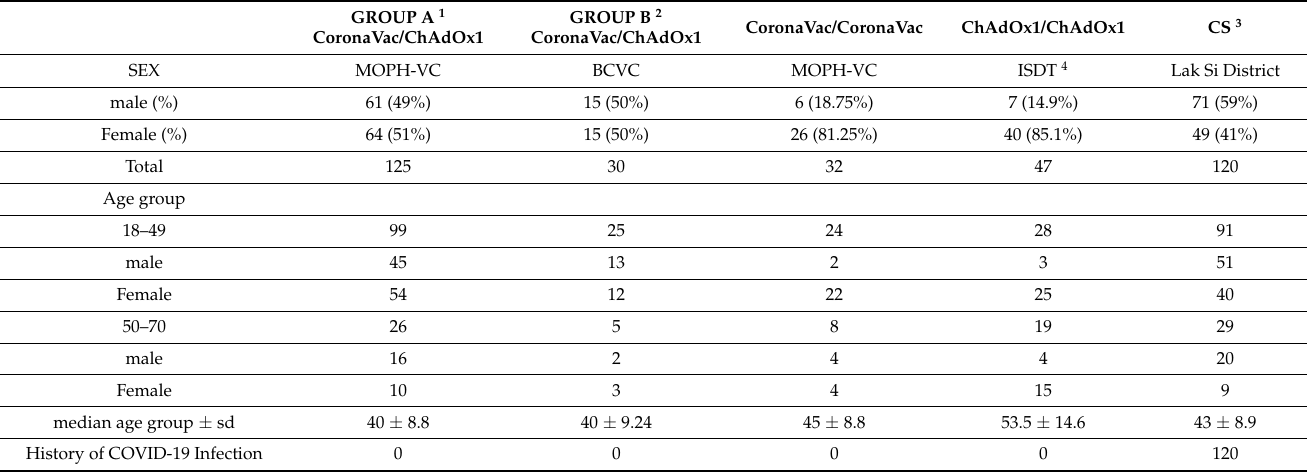
Table 1. Demographic data of the study